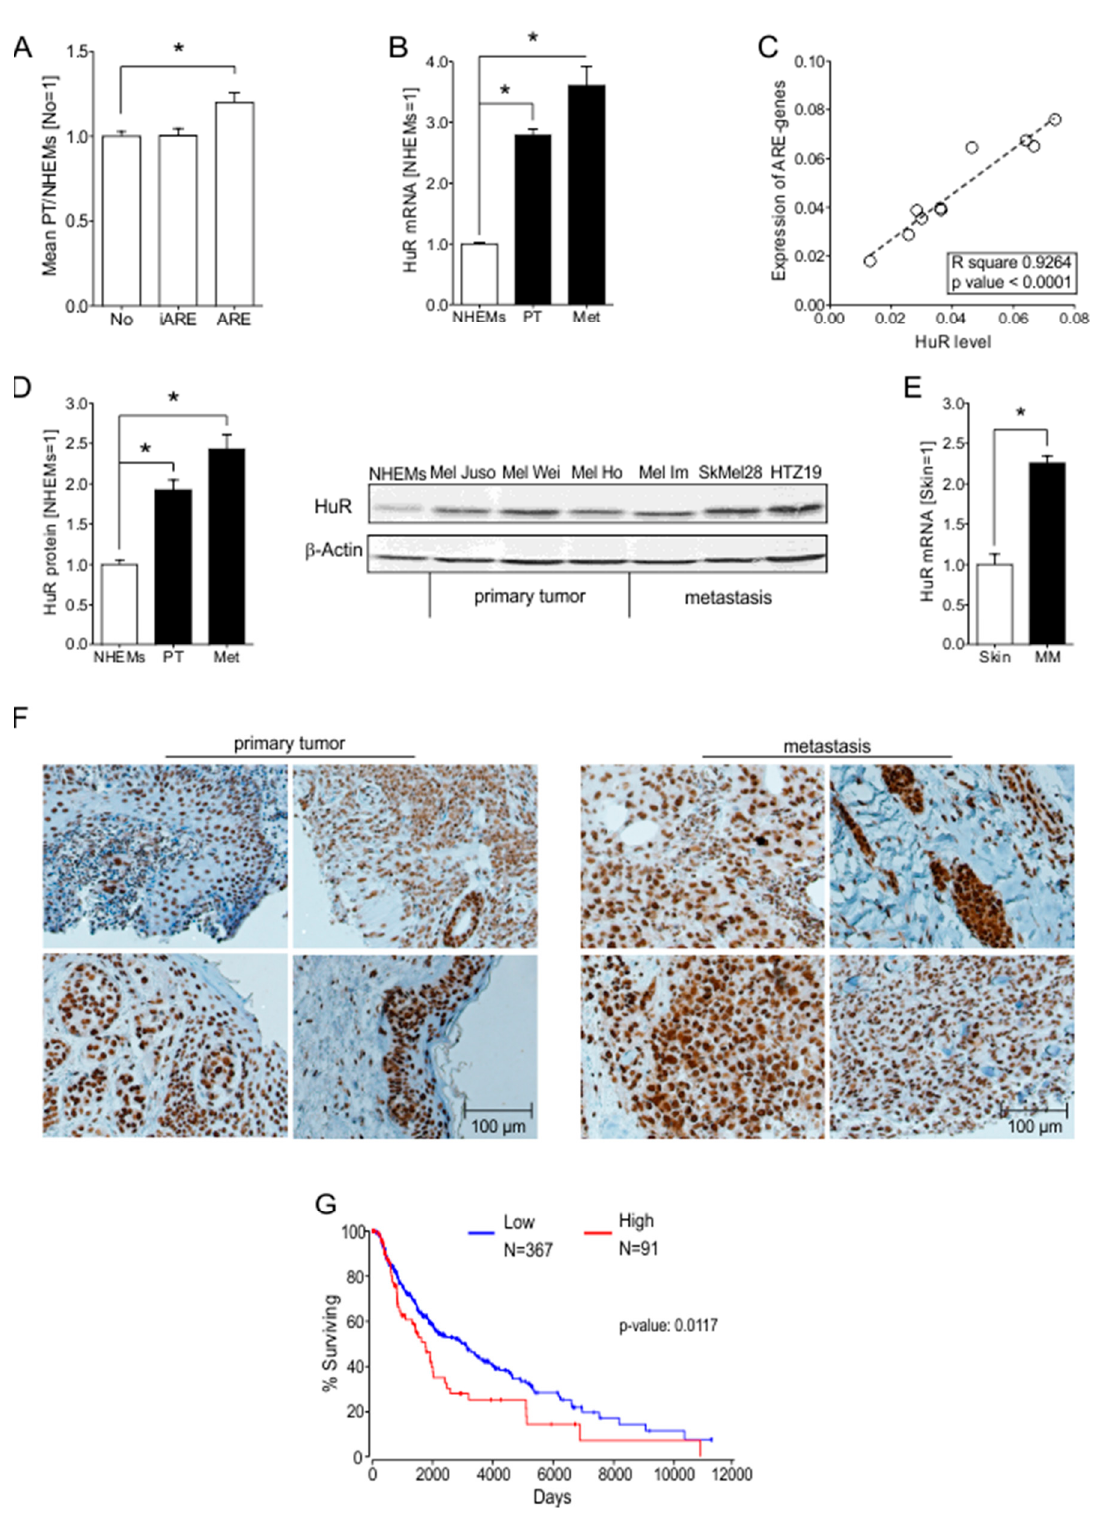
Figure 1. HuR ( ELAVL1 ) expression in malignant melanoma in vivo and in vitro . ( A ) Mean expression of mRNAs in primary melanoma cells related to expression in NHEM cells. No = mRNAs without ARE binding sequence ( n = 9993); iARE = mRNAs with ≥ 1 intronic ARE sequence ( n = 5560); ARE = mRNAs with ≥ 1 ARE sequence in the 3 ′ UTR ( n = 2095). ( B ) Relative expression of HuR mRNA in NHEMs and melanoma cell lines, mRNA level in NHEMs is set 1. ( C ) Correlation of HuR expression, and the mean expression of 150 randomly chosen ARE containing mRNAs in 10 different melanoma cell lines. ( D ) Densitometric quantification (left) and exemplary image (right) of Western blot analysis of HuR protein levels in primary and metastatic melanoma cell lines compared to NHEMs. HuR